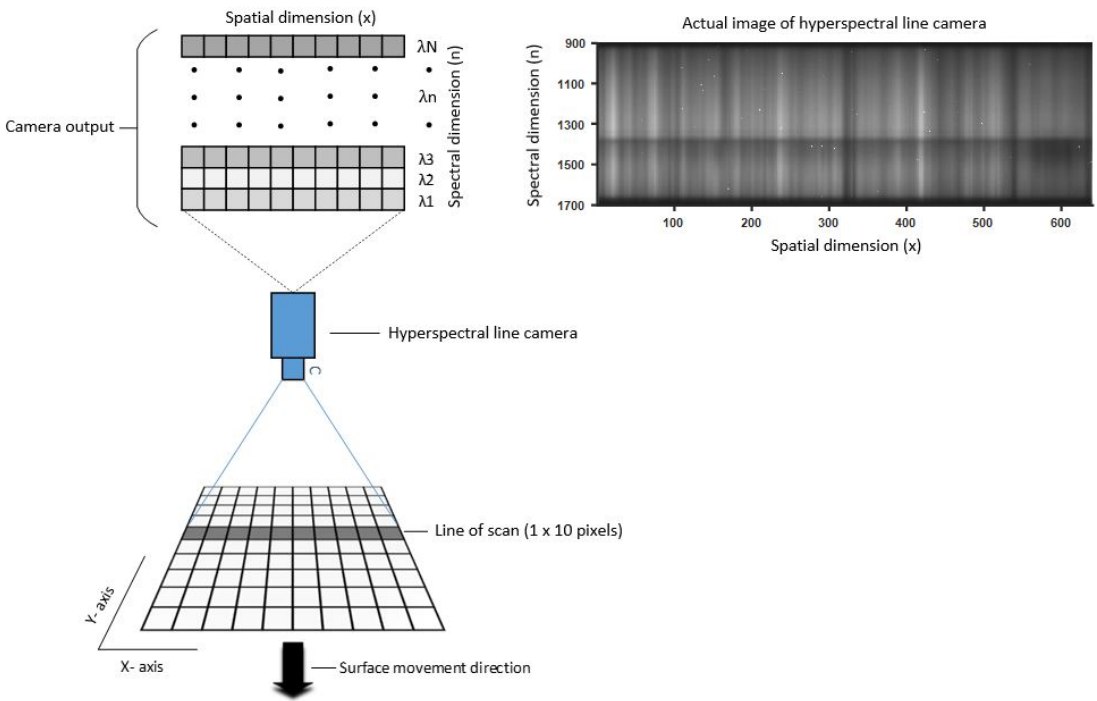
Figure 1. Depiction of the hyperspectral camera in use and the output of the camera.